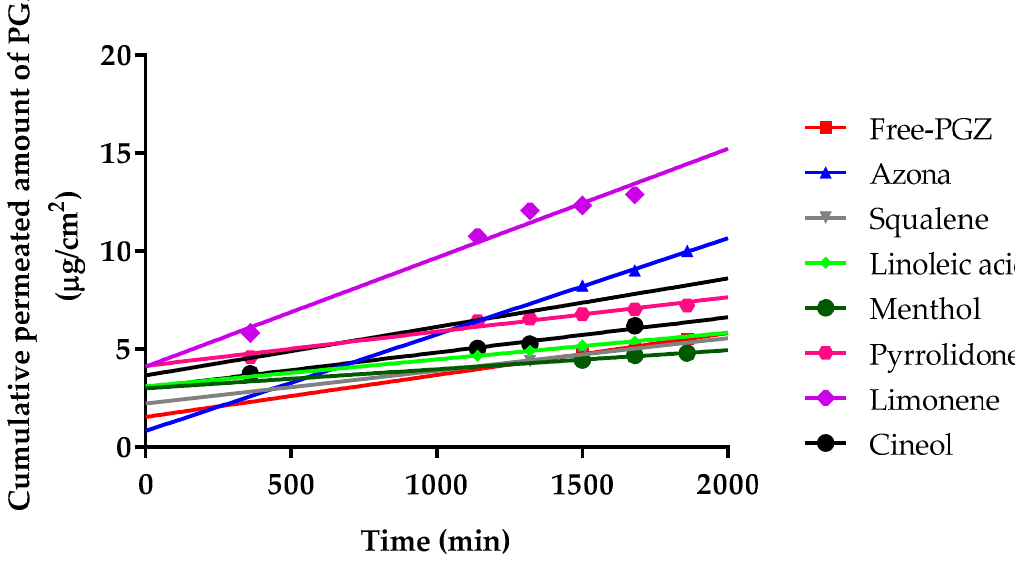
Figure 1. Median cumulative permeated amount of pioglitazone (PGZ) with and without penetration enhancers through human skin, expressed as μ g/cm 2 .